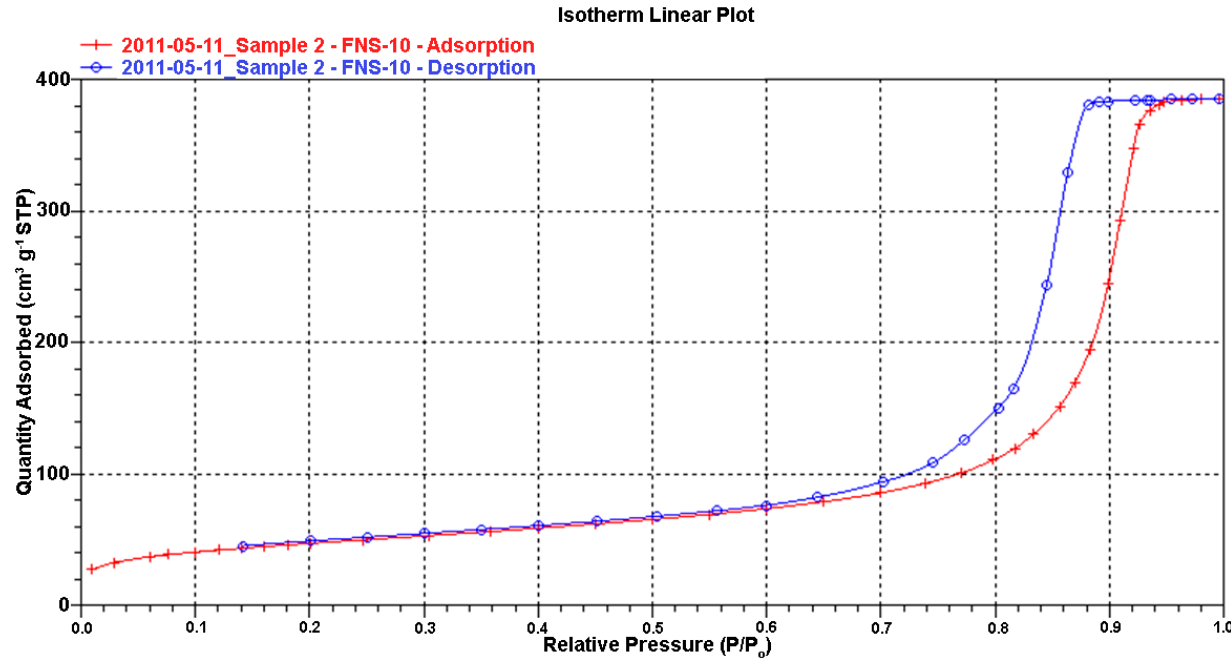
Figure 5. Nitrogen (N 2 ) adsorption/desorption isotherms of FNS sorbent. X -axis is the p/p o - the relative pressure of the nitrogen gas; p o is the saturated gas pressure, Pa; Y -axis is the amount of adsorbed nitrogen gas, cm 3 g –1 of the sorbent.